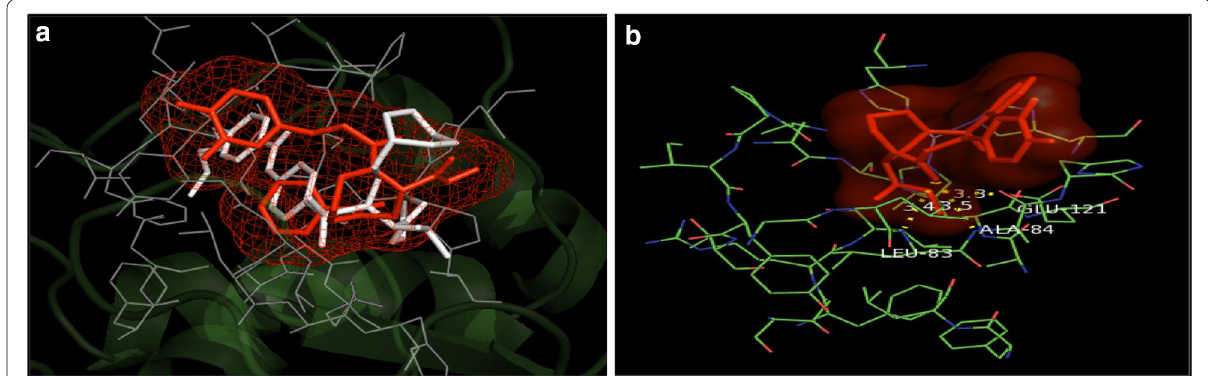
Fig. 6 a Overlay of the docked pose of compound 15 (red) with that of PDB Ligand 1HOV (white); b docked pose: H-bond interaction of com- pound 15 in the binding site of MMP-2 protein